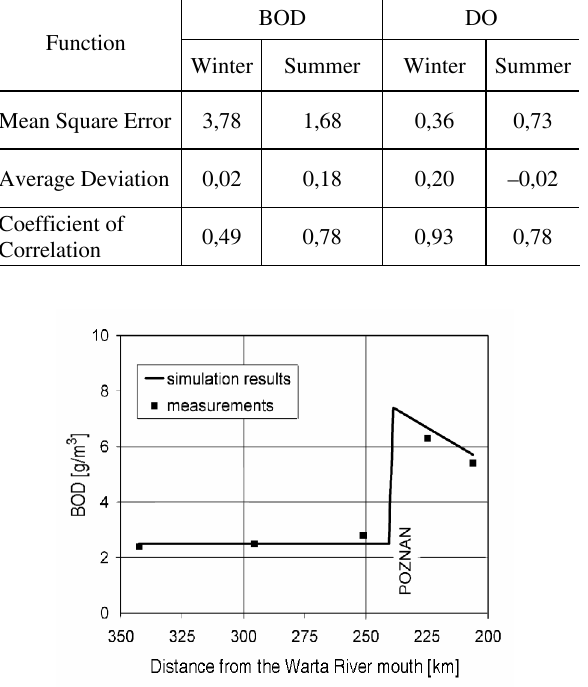
Fig 2. Comparison of measured and simulated BOD con- centrations in analysed reach of the Warta River for 2 July 2002